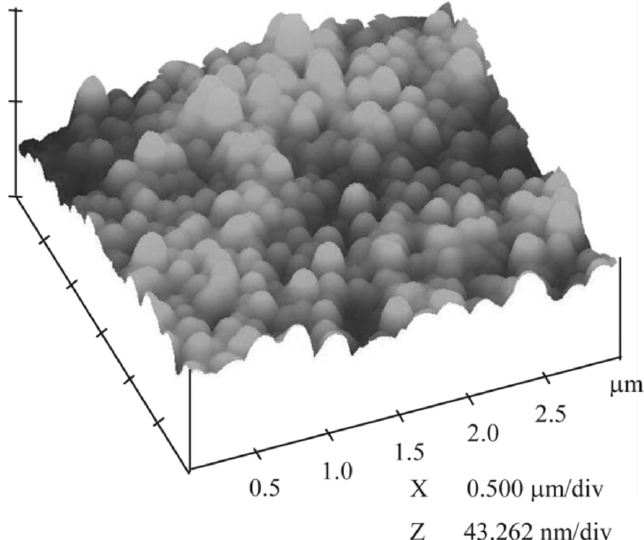
Figure 10. Adapted with permission from Jing-Xiao Liu et al. [51]. Copyright 2003 Elsevier. License number 5318830382484. AFM image of TiO 2 coating generated by sol-gel and deposited on NiTi